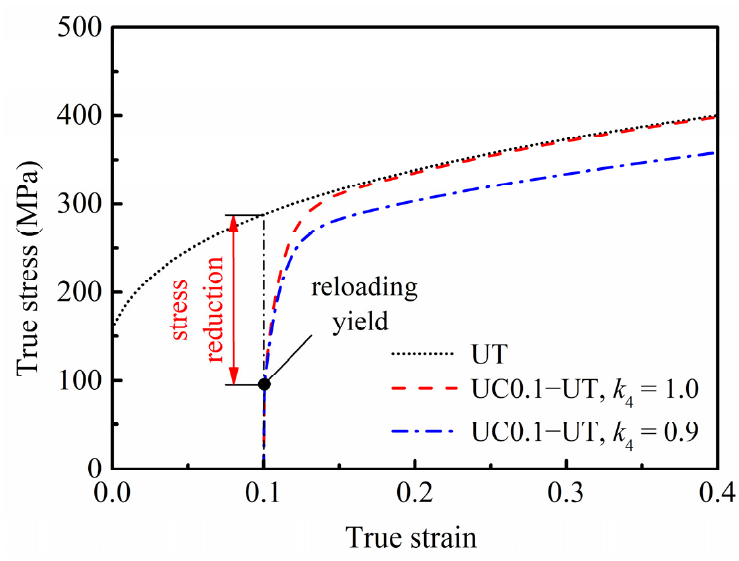
Figure 5. True stress–strain curves of the generic material predicted by the HAH-2d model in a uniaxial compression-tension loading path. uniaxial compression-tension loading